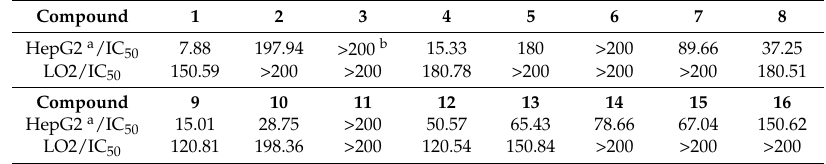
Table 1. Urushiol derivatives inhibitory activity against HepG2 and LO2 in vitro (IC 50 , μ M, 72 h).